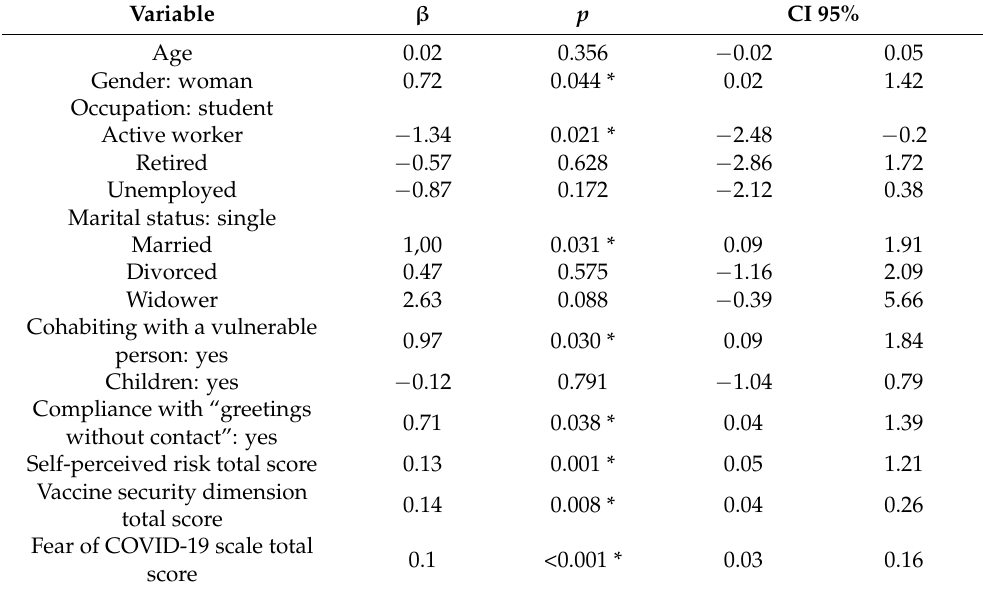
Table 5. Regression model: vaccination for health-related